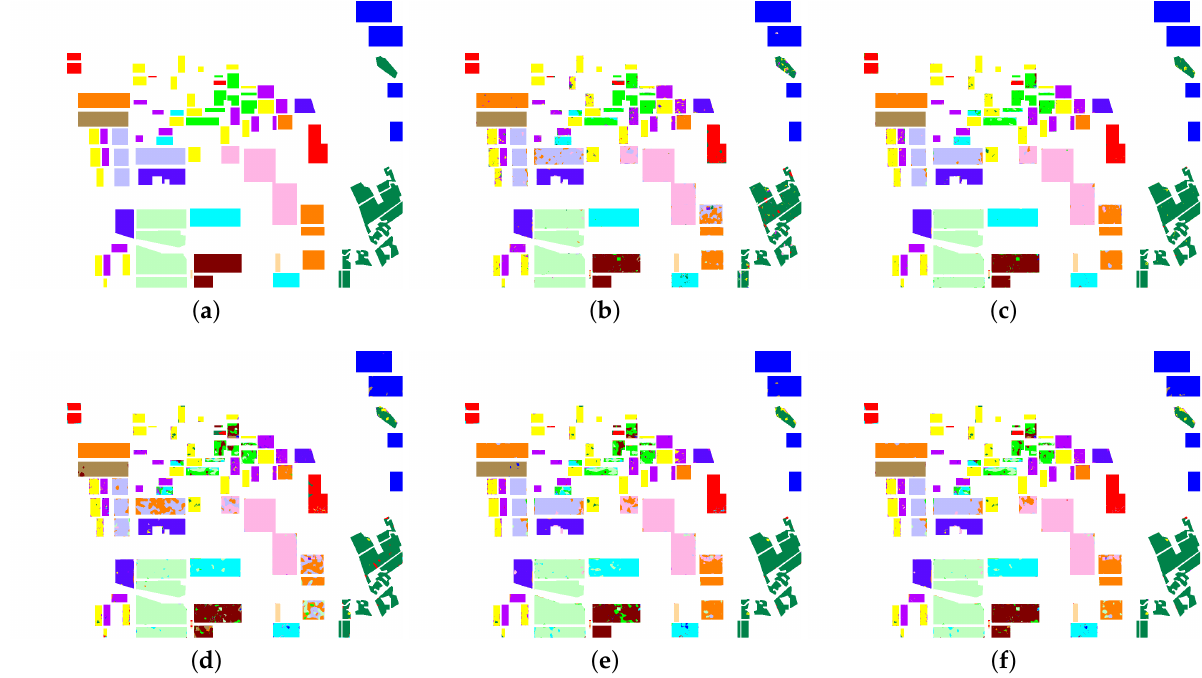
Figure 11. Classification results of five classifiers on the ground-truth map of Flevoland image: ( a ) Ground-truth map, ( b ) SVM_PP, ( c ) SVM_LP, ( d ) ANN_Opt, ( e ) ANN_MIM, and ( f )